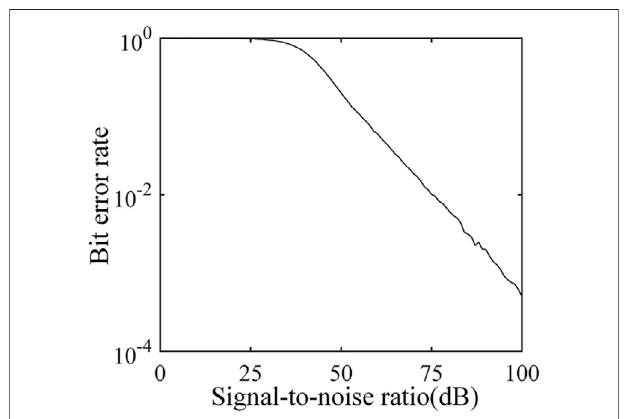
FIGURE 7 | BER performance under additive white Gaussian noise (AWGN) channels.